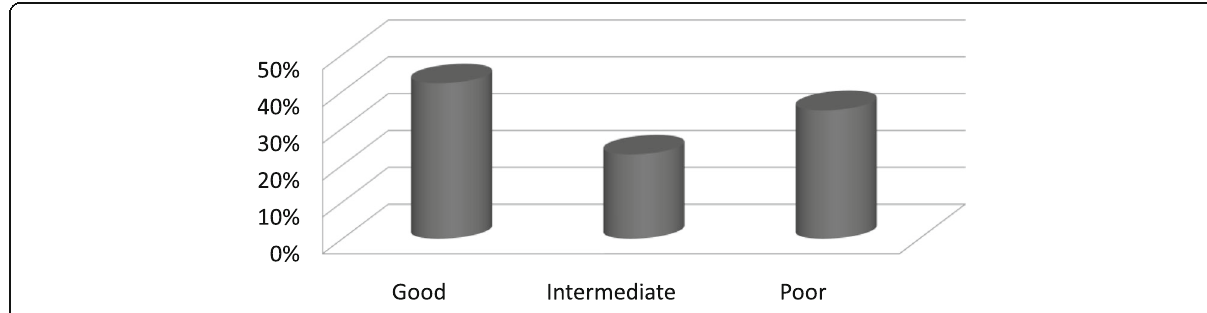
Fig. 1 Level of adherence among patients with bronchial